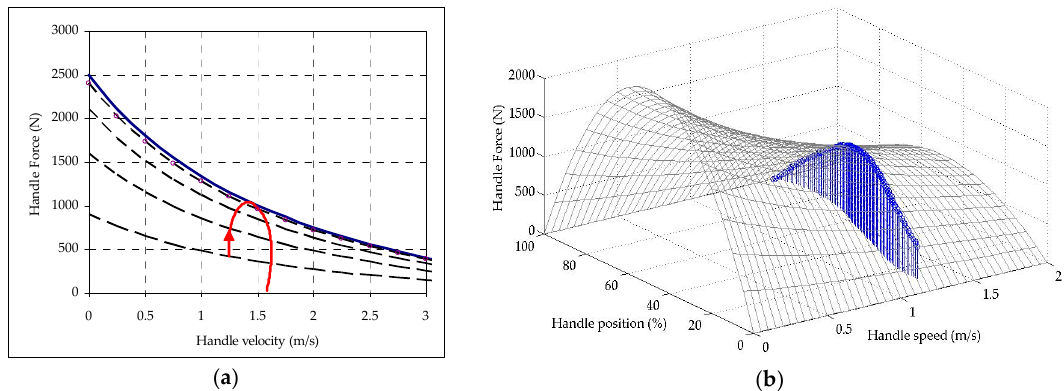
Figure 2. Coupled athlete F-v-l model with the ergometer resistance model. ( a ) Black hyperbolae show the athlete F-v-l relationship (the top solid line is the F max -v curve, while the successively lower dashed curves are parabolic decrements as the rower “position” l diverges from the peak. In red is the coupled result, with time progression given by the arrow. ( b ) The same plot as a 3D trajectory on the surface of athlete maximal muscle force application. Time progression is in the direction of increasing handle